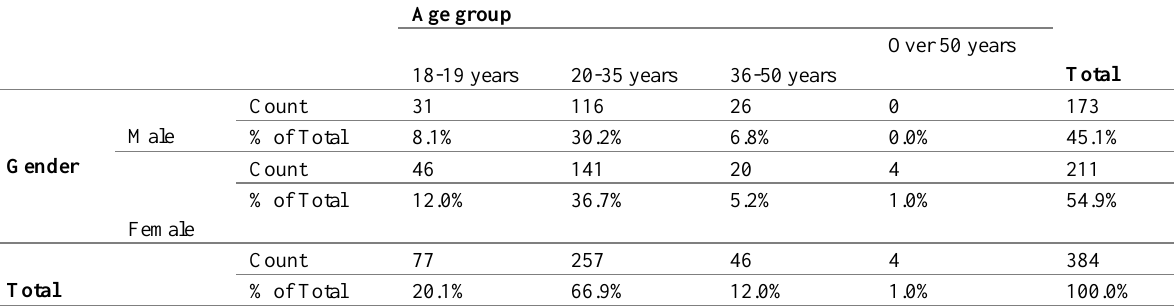
Table 3: Gender distribution by age